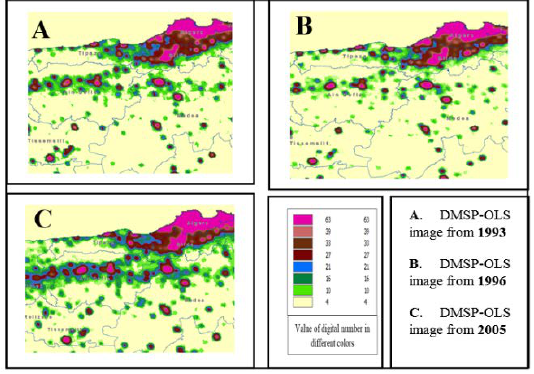
Figure 5. Growth sum of light observed from human settlements and the light from gas flaring in Algeria (1993-2012).